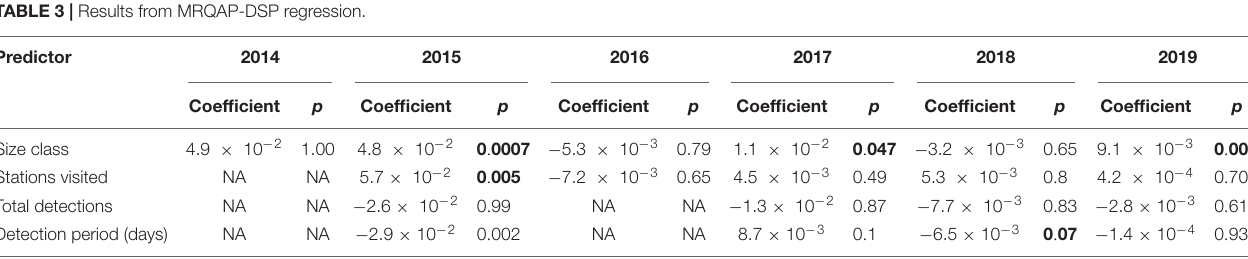
TABLE 3 | Results from MRQAP-DSP